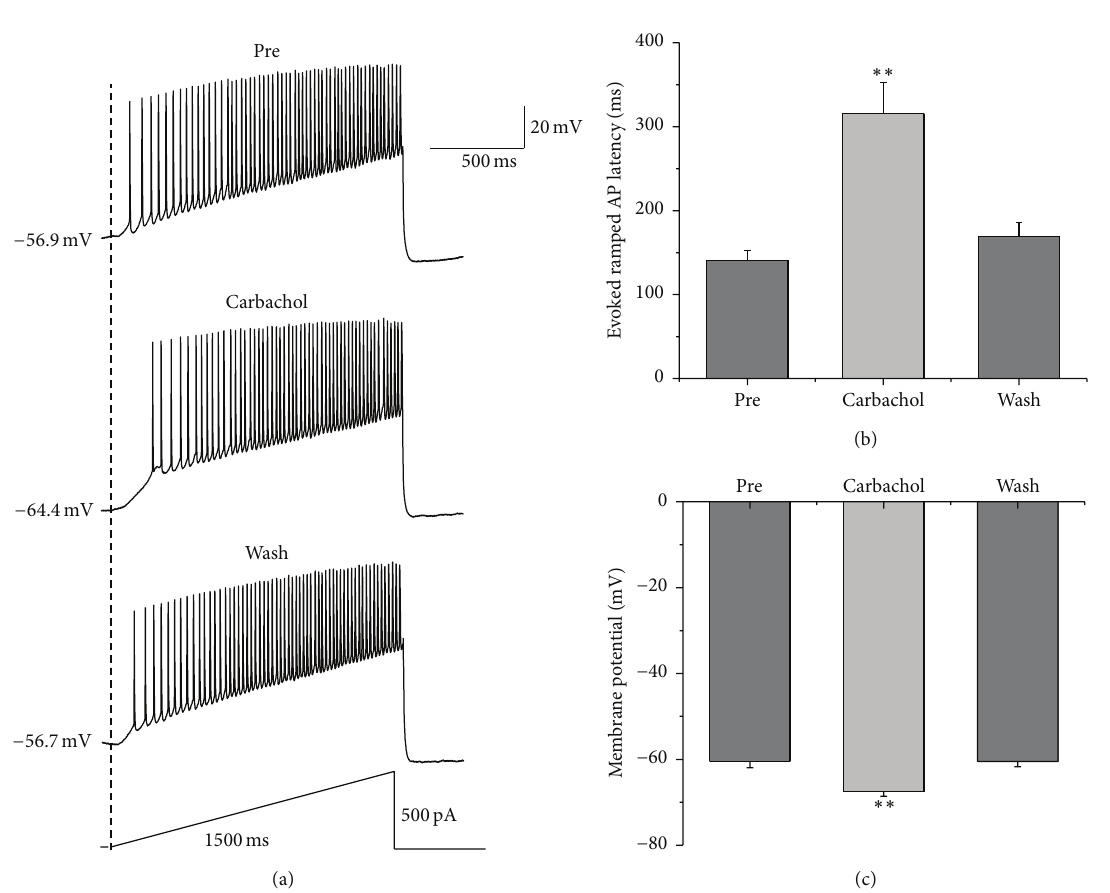
Figure 3: Effects of 30 𝜇 M carbachol on the AP firing of RA projection neurons evoked by a depolarizing ramp stimulus. (a) Sample traces of AP firing evoked by a ramp current before, during, and after the application of carbachol. (b) The evoked ramped AP latency was significantly increased in the presence of carbachol ( 𝑛 = 23 , the latency is determined from the time between the onset of the stimulus and the first evoked AP for each cell). (c) Membrane potential was significantly hyperpolarized in the presence of carbachol ( 𝑛 = 23 ). ∗∗ means 𝑝 < 0.01 , paired 𝑡